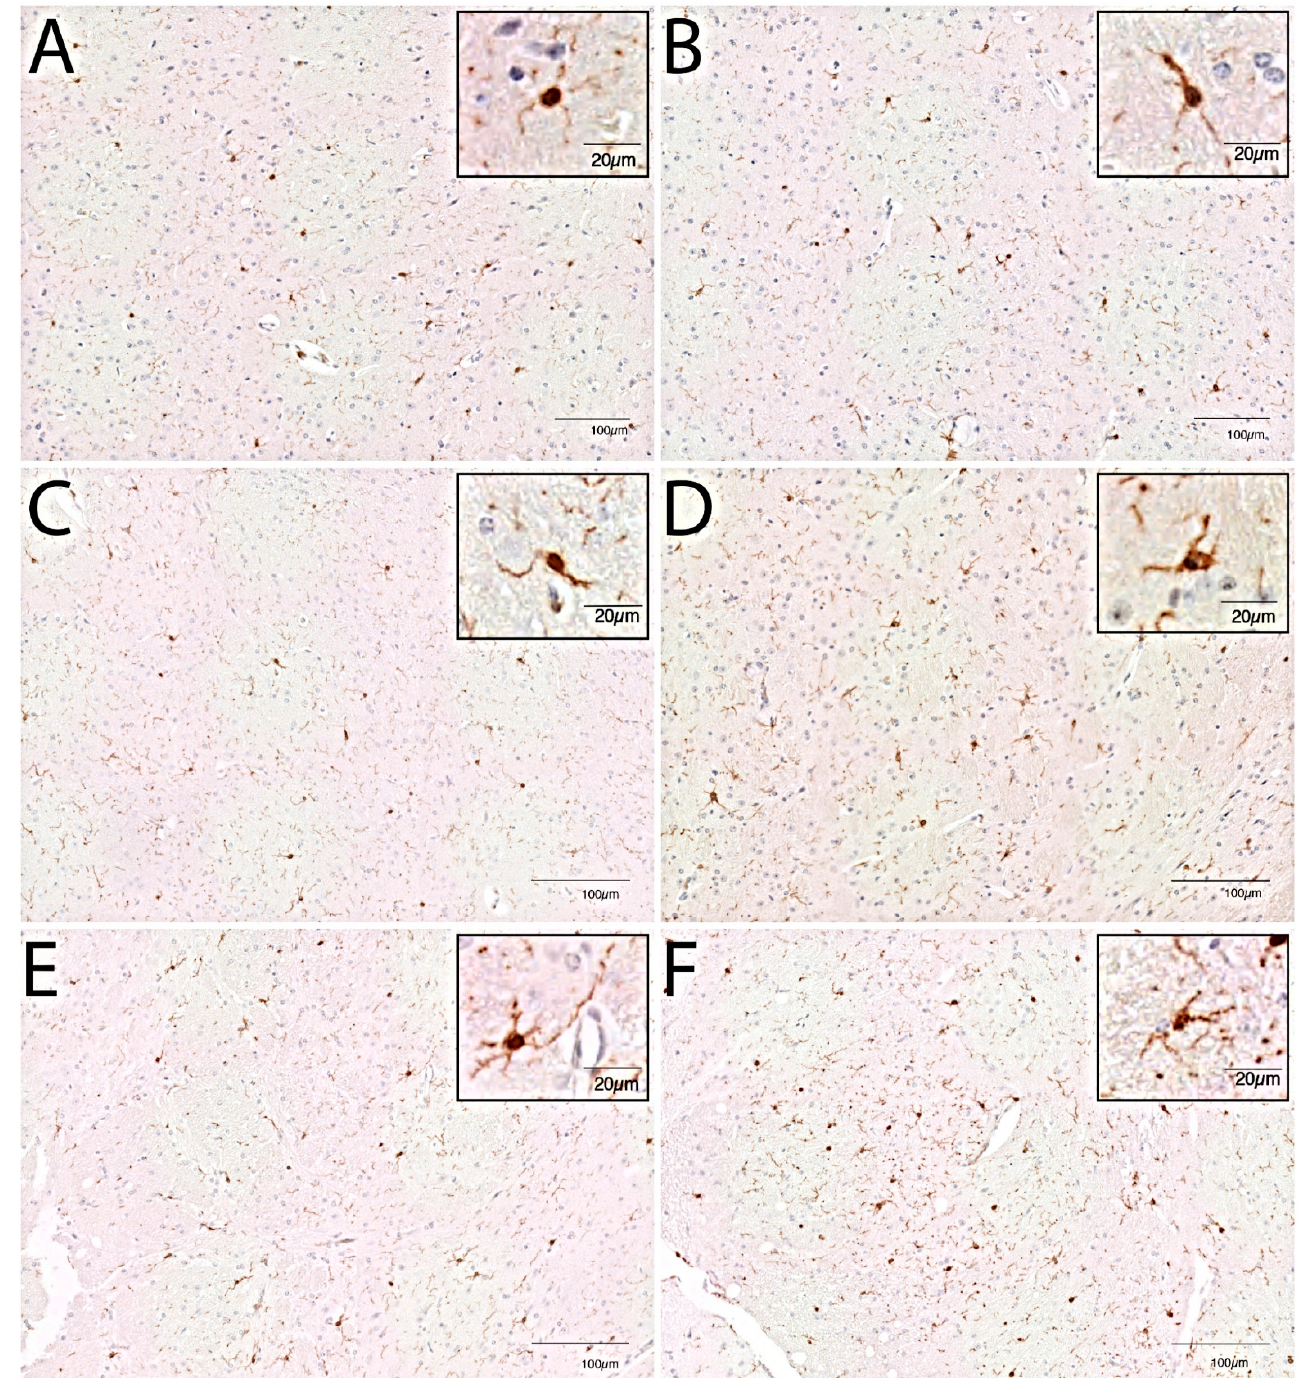
Figure 3. Representative images of immunohistochemical staining with Iba-1 antibody of thalamus region for young control mice given NaCl and ceftriaxone, sacrificed at day 7 ( A ), middle-aged control mice given NaCl and ceftriaxone, sacrificed at day 7 ( B ), young infected mice given E. coli and ceftriaxone, sacrificed at day 3 ( C ), middle-aged infected mice given E. coli and ceftriaxone, sacrificed at day 3 ( D ), young infected mice given E. coli and ceftriaxone, sacrificed at day 7 ( E ), and middle-aged infected mice given E. coli and ceftriaxone, sacrificed at day 7 ( F ).